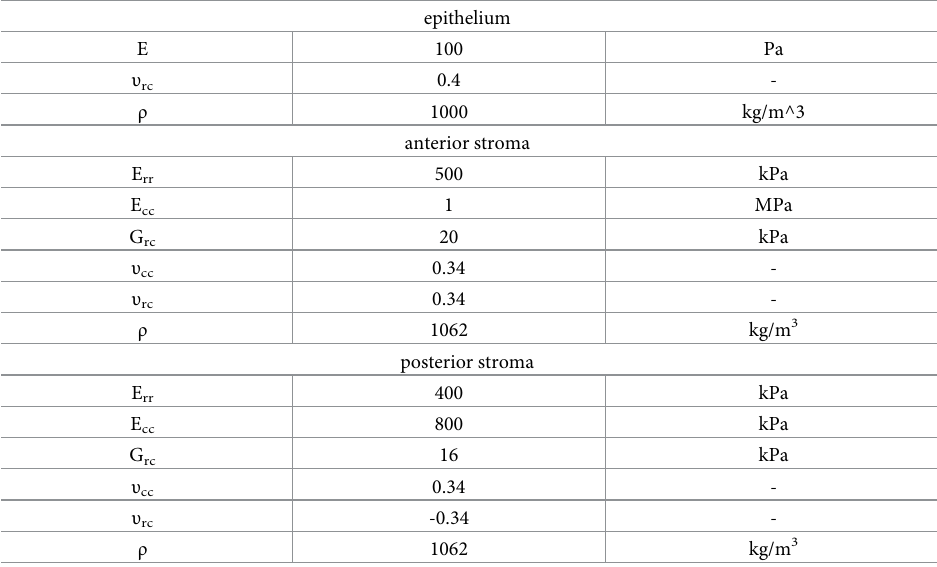
Table 1. Material constants applied in the finite element model.